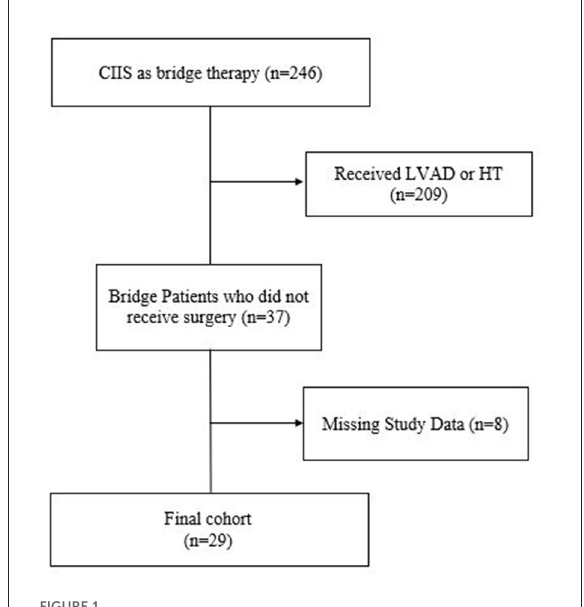
FIGURE1 Flow diagram of patients initiated on CIIS as bridge therapy and who ultimately did not receive surgical therapy.